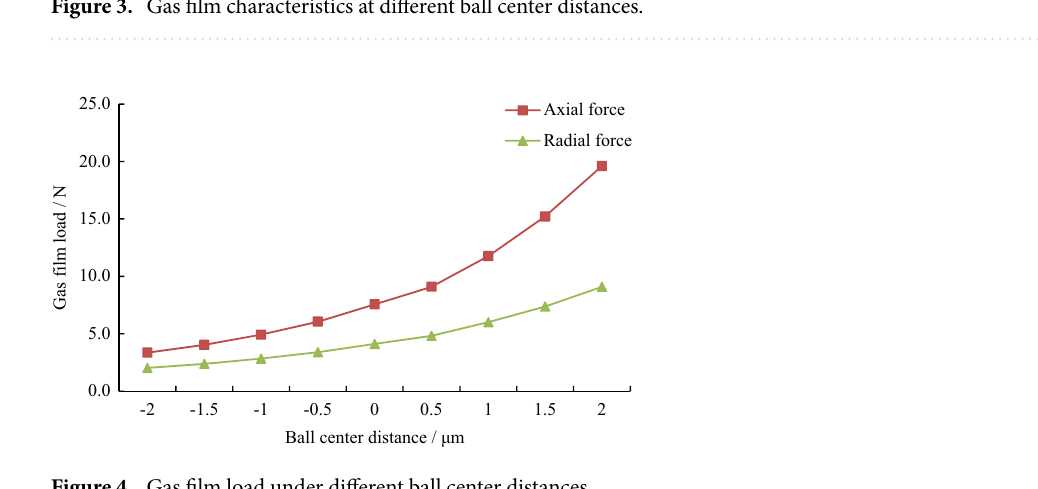
Figure 4. Gas film load under different ball center